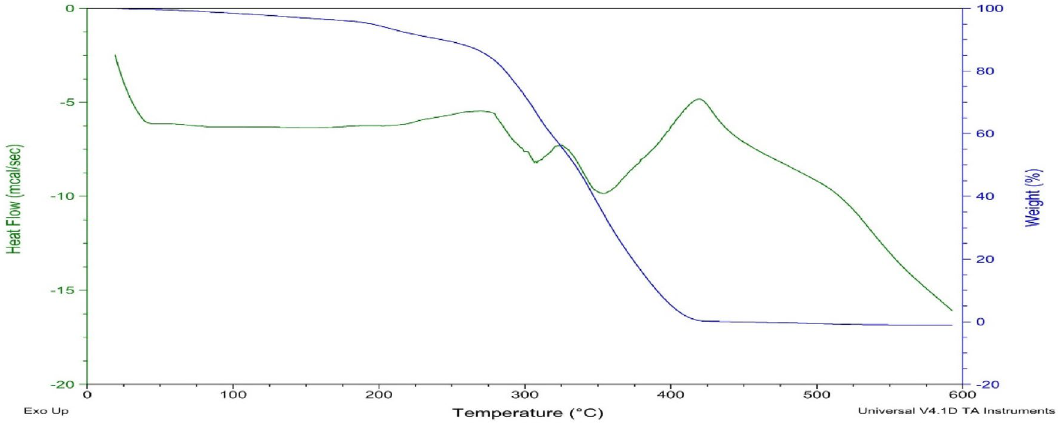
Figure 11. DSC/TGA of CPS-5.